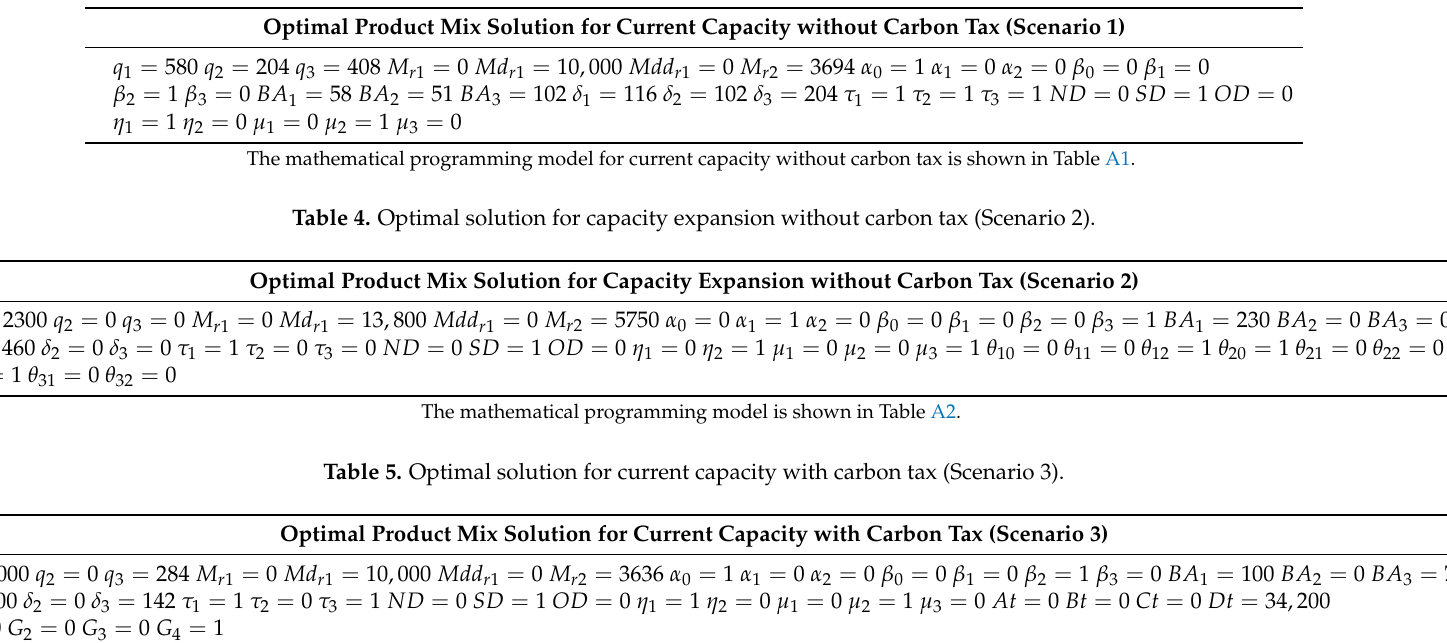
Table 3. Optimal solution for current capacity without carbon tax (Scenario 1).